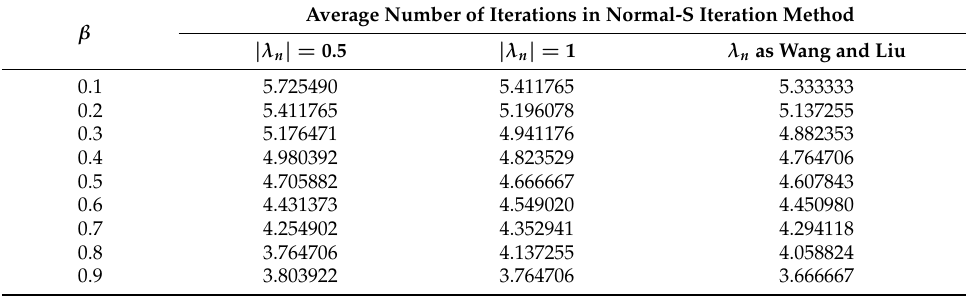
Table 6. The average number of iterations (ANI) in normal-S iteration method.